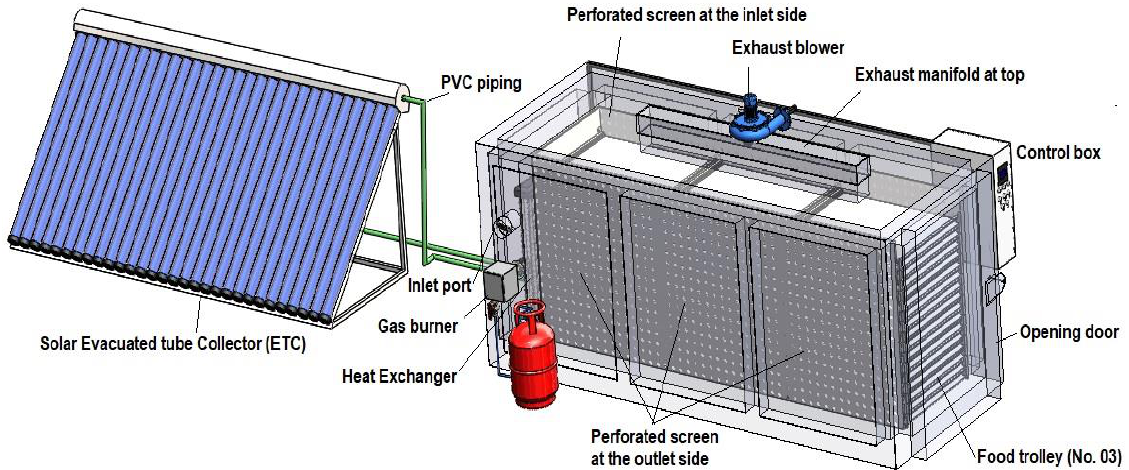
Figure 1. Solar hybrid dehydrator used in the current study [2].